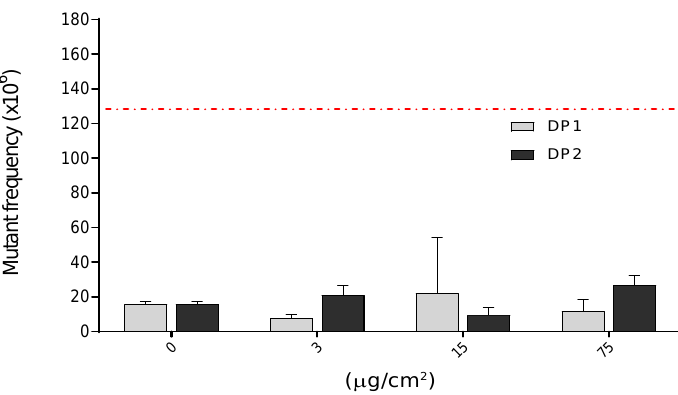
Figure 5. Induction of Hprt gene mutants after the exposure of V79-4 cells to different concentrations of TiO 2 NPs for 24 h. There were no statistical significances between exposed and unexposed cultures. Hprt gene mutant frequency in treated cells with positive control MMS (0.1 mM, 3 h), which gave 131.6 ± 2.30 Hprt gene mutants. This value is indicated as a red-dashed line. Data are expressed as the means ± SEM of two parallel seedings for mutation frequency MF1 and MF2, according to the used procedure.